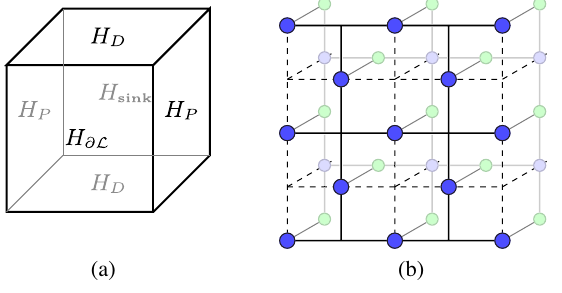
FIG. 10. (a) The boundaries of the cubic RBH model. H ∂ L is the toric code boundary, H and H are the primal and dual P D boundaries, respectively, and H is the sink boundary. sink (b) The lattice for the toric code boundary H ∂ L . The top and bottom edges are called rough boundary conditions, while the left and right edges are called smooth boundary conditions. The Hamiltonian consists of the negative sum of all star and plaquette ¯ ¯ B A terms , from Eq. (24). Dashed lines denote edges of the cubic v f lattice.